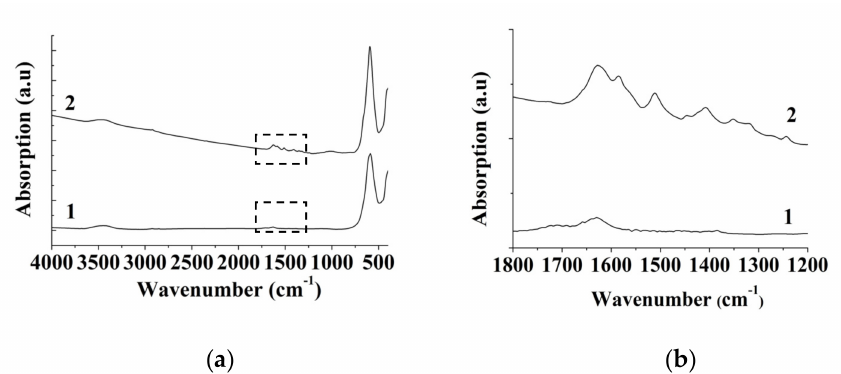
Figure 2. FT-IR-spectra of cobalt ferrite nanoparticles in the spectral region of 4000–500 cm − 1 ( a ) and enlarged spectra in the region of 1800–1200 cm − 1 (highlighted in the figure a with a rectangle) ( b ) synthesized by anion-exchange resin co-precipitation in a solution of FeCl 3 , CoCl 2 and 10% dextran-40 at 60 ◦ C and annealed at 600 ◦ C for 1 h before (1) and after (2) treatment by methionine (20 mL, 0.03